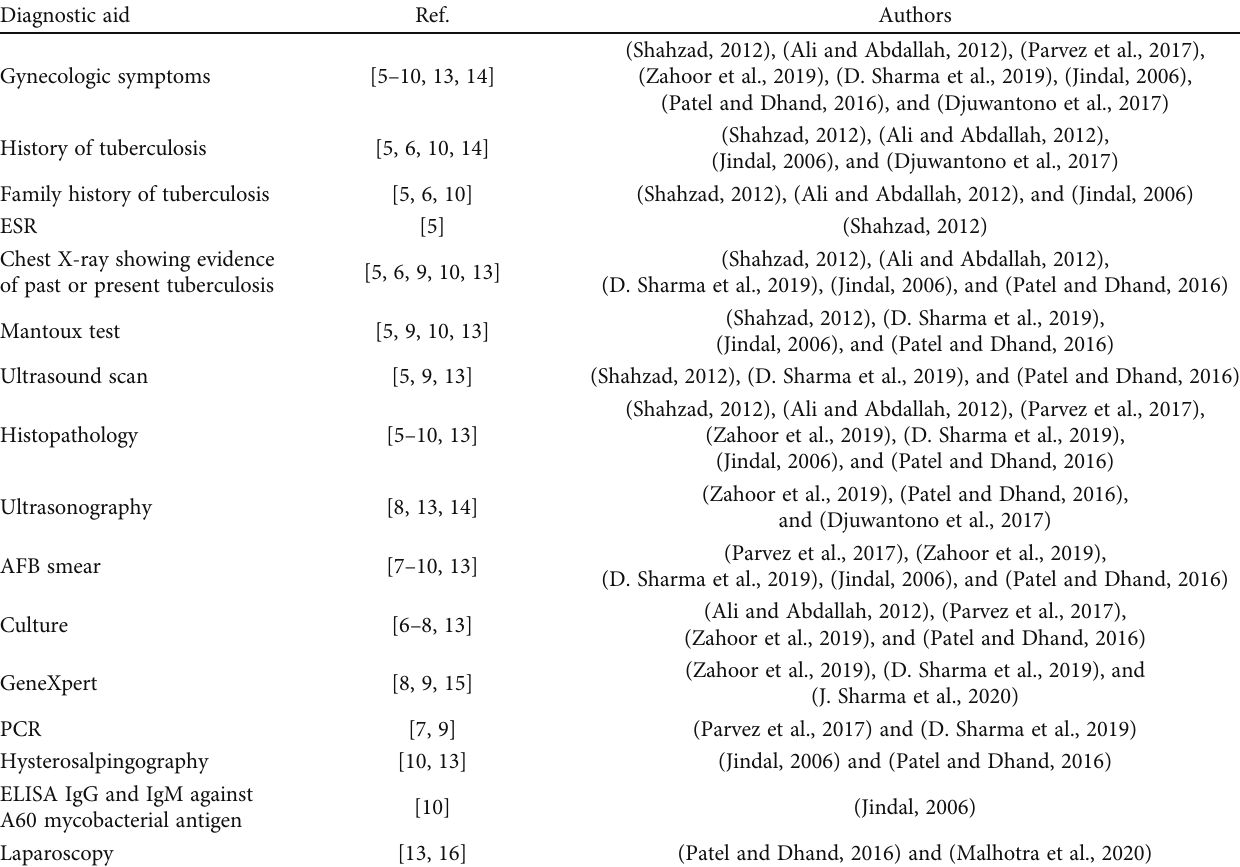
Table 3: Test combination for the diagnosis of genital